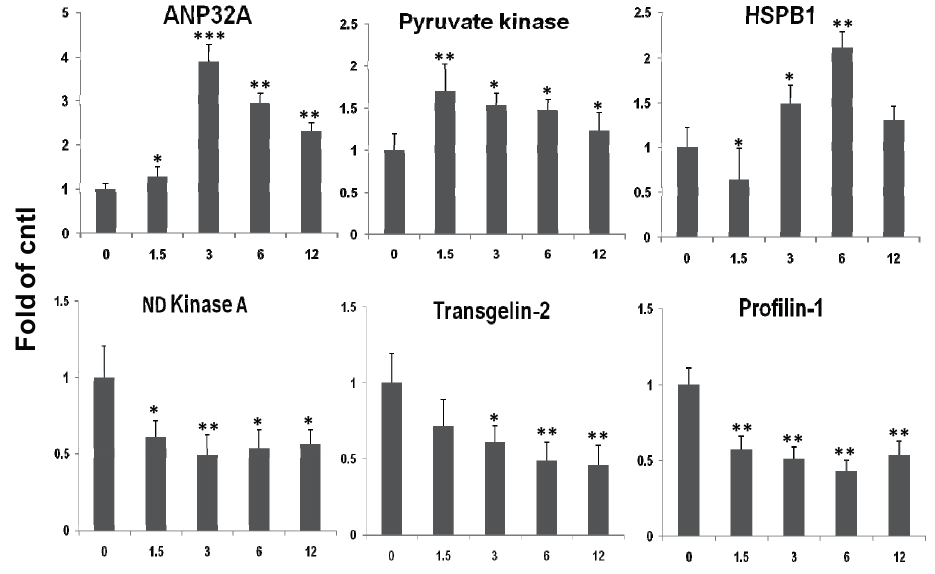
Figure 2. Real-time PCR analysis of transcript levels of 6 among 12 identified